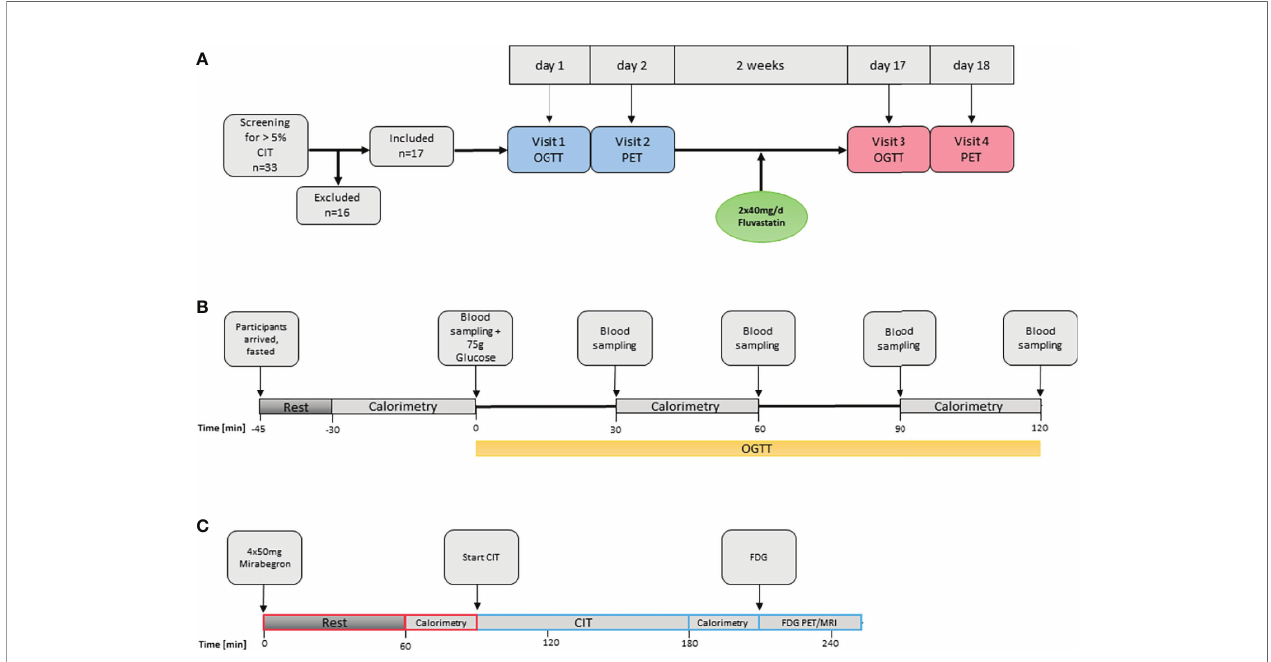
FIGURE 1 | Overview of study procedures. (A) Overall study fl ow. CIT, cold induced thermogenesis; OGTT, oral glucose tolerance test. (B) Oral glucose tolerance test and assessment of diet-induced thermogenesis. (C) Assessment of BAT function. FDG,